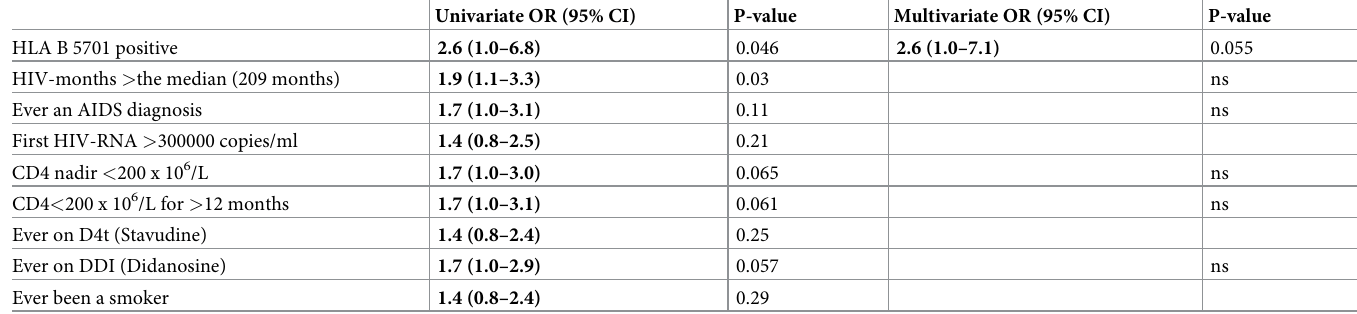
Table 3. Uni and multivariate analysis regarding T2D in all patients including patients with diabetes (n = 570) at baseline. The multivariate analysis was controlled for age. All parameters with p < 0.20 in the univariate analysis were entered in the multivariate equation. OR and 95% confidence